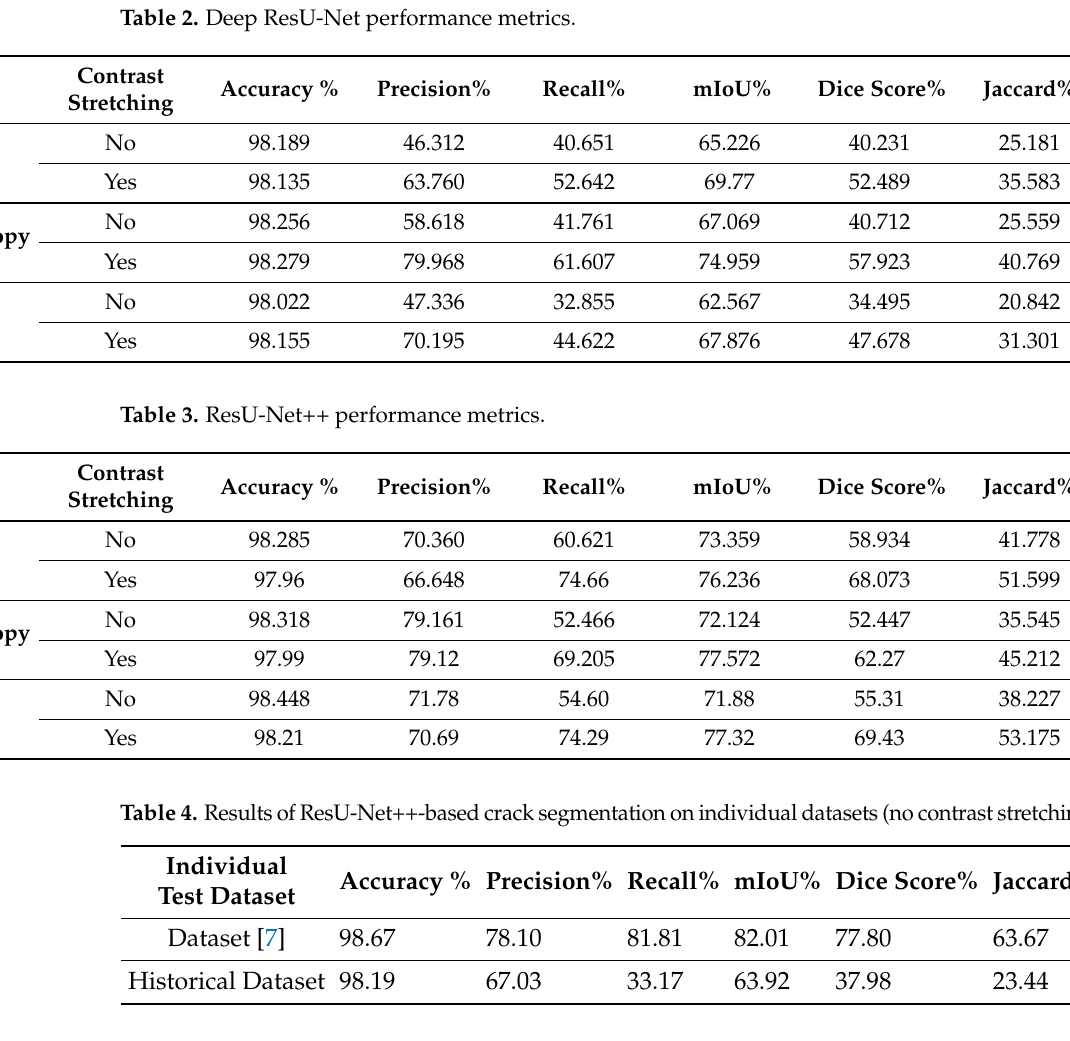
Table 5. Results of ResU-Net++-based crack segmentation on individual datasets (with contrast stretching).